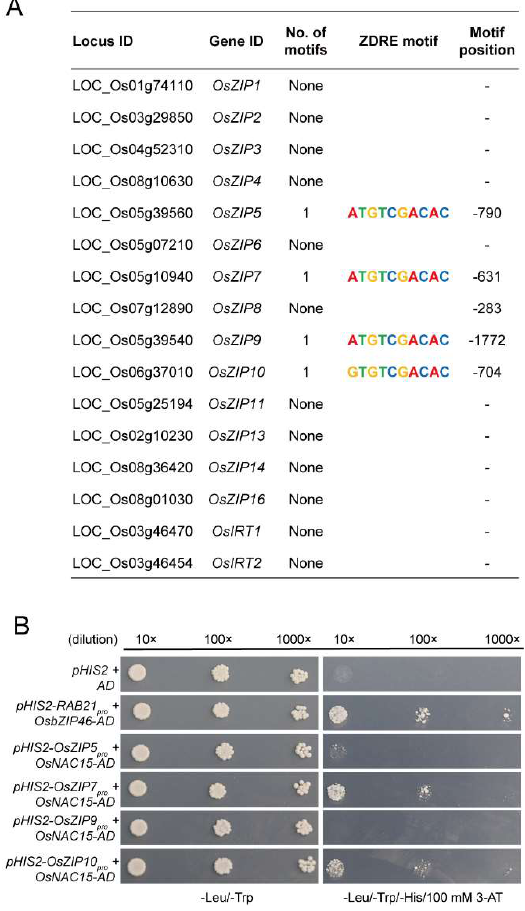
Figure 7. Identification of OsNAC15 target genes among the rice ZIP family genes. ( A ) Analysis of the number and position of detected ZDRE elements in the promoter of each gene. Position of the first nucleotide of the ZDRE motif in relation to the start codon. ZDRE consensus sequence (RTGTCGACAY). ( B ) Yeast one-hybrid assay; 100 mM 3-AT was added in the SD-Leu/-Trp/-His medium. Interaction between OsbZIP46 and RAB21 was used as positive control. Dilutions of 10×, 100× and 1000× correspond to an OD600 of 0.1, 0.01 and 0.001. To further confirm whether OsNAC15 binds to the ZDRE motif in the OsZIP7 and OsZIP10 promoters, we performed the transient transcriptional activity assay using the dual-luciferase reporter system. In the dual-luciferase experiment, OsZIP7pro:LUC and OsZIP7-4pro:LUC or OsZIP10pro:LUC and OsZIP10-3pro:LUC were co-transiently trans- formed with empty vector or 35Spro:OsNAC15 into tobacco epidermal cells,